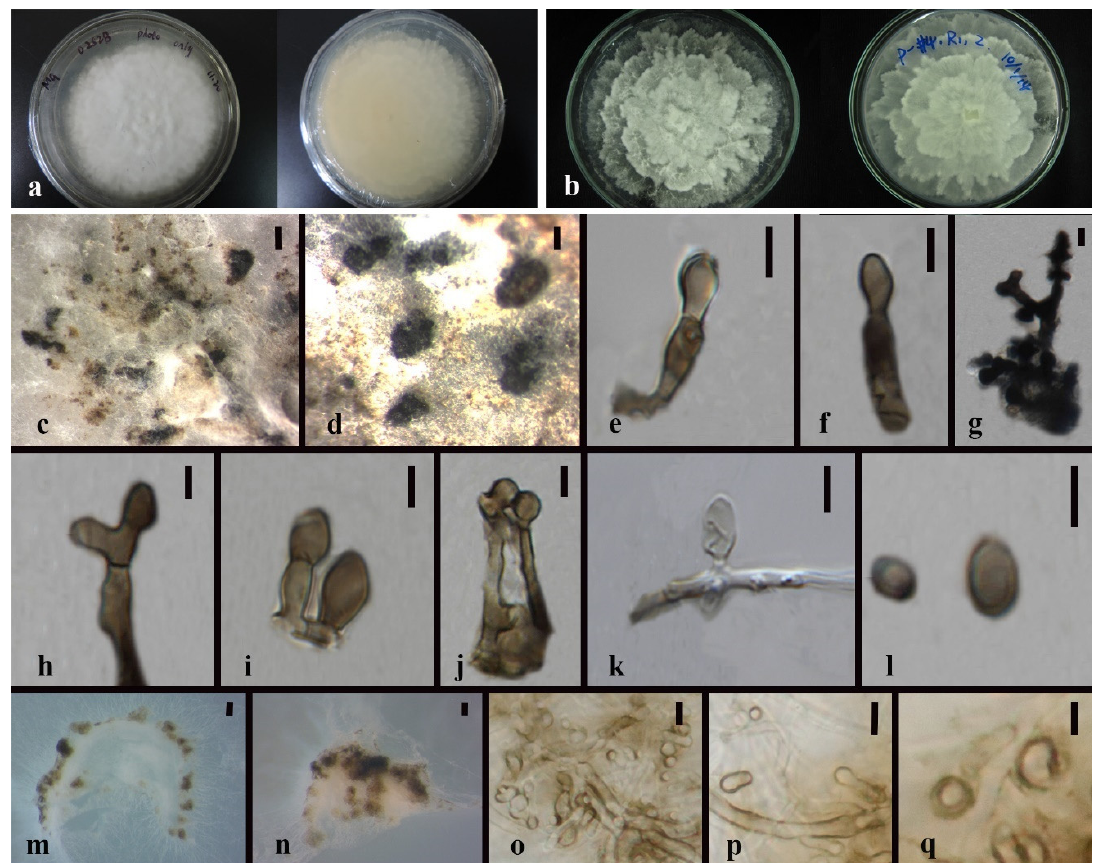
Figure 12. Nemania bipapillata (MFLUCC 14-0105). ( a ) Colony on PDA (MFLUCC 14-0105) (left-front view, right-reverse view). ( b ) Colony on PDA (MFLUCC 14-0138) (left-front view, right-reverse view). ( c , d ) Conidiomata. ( e , f ), ( h – j ) Conidiophores with conidia. ( g ) Stromatic hypha with protuberances. ( k ) Chlamydospores. ( l ) Conidia. ( m – n ) Conidiomatal masses. ( o – q ) Conidia. Notes: ( c – l ) on PDA, ( m – q ) on WA. Scale bars: ( c , d ) = 200 μ m, ( e – l ) = 5 μ m, ( m – n ) = 500 μ m, ( o ) = 10 μ m, ( p , q ) = 5 μ m.